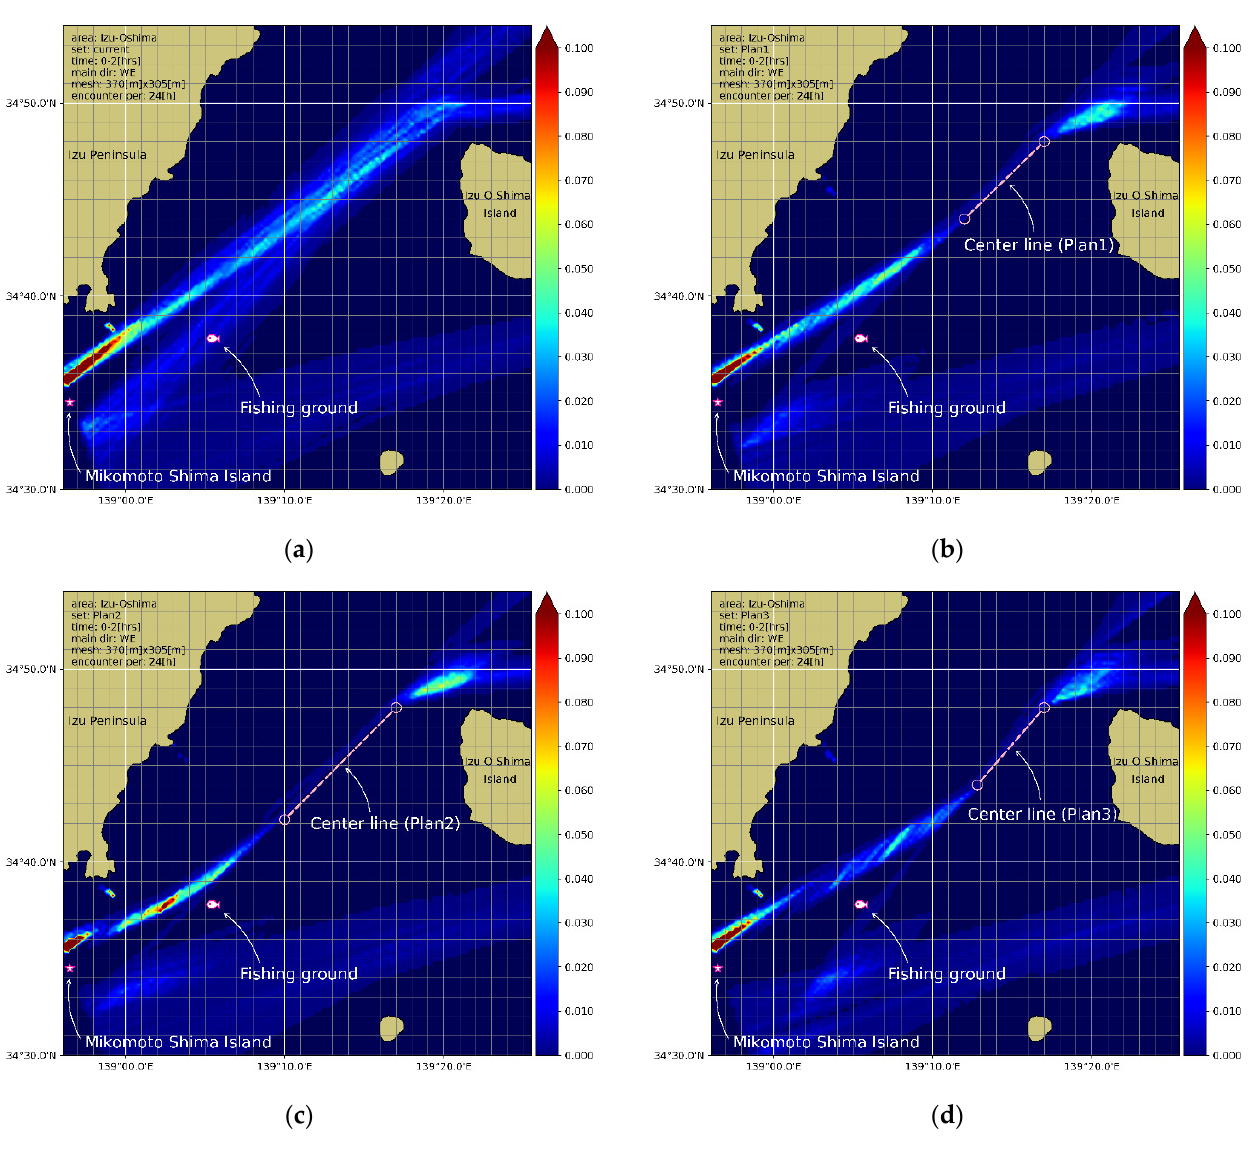
Figure 12. Distribution map of the encounter frequency for 24 h at nighttime: ( a ) present traffic, ( b ) Plan 1, ( c ) Plan 2, and ( d ) Plan 3. (Sources: simulation results data of [8]).